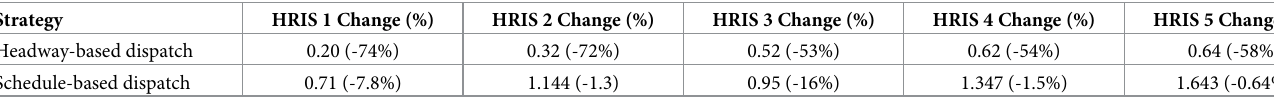
Table 11. Effect of terminal dispatch strategies on headway regularity